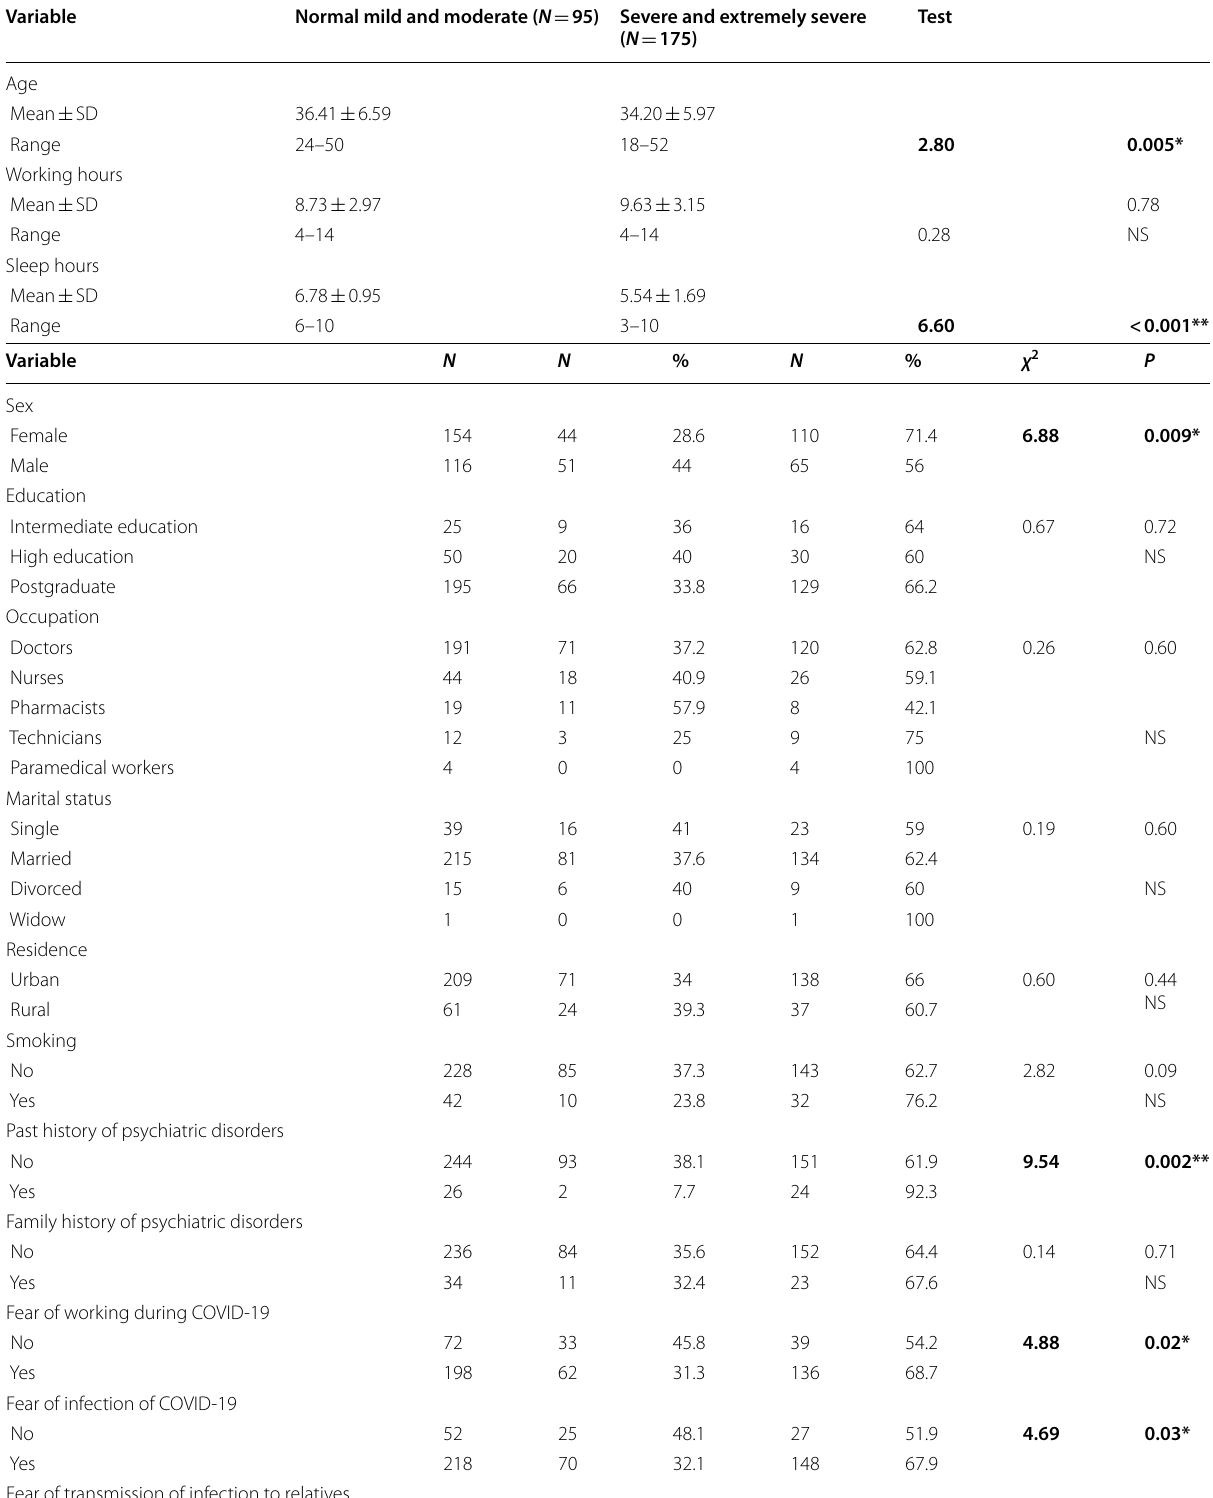
Table 1 Comparison between those who are normal, mild and moderate depression and those with severe and extremely severe depression according to DASS-21 depression score